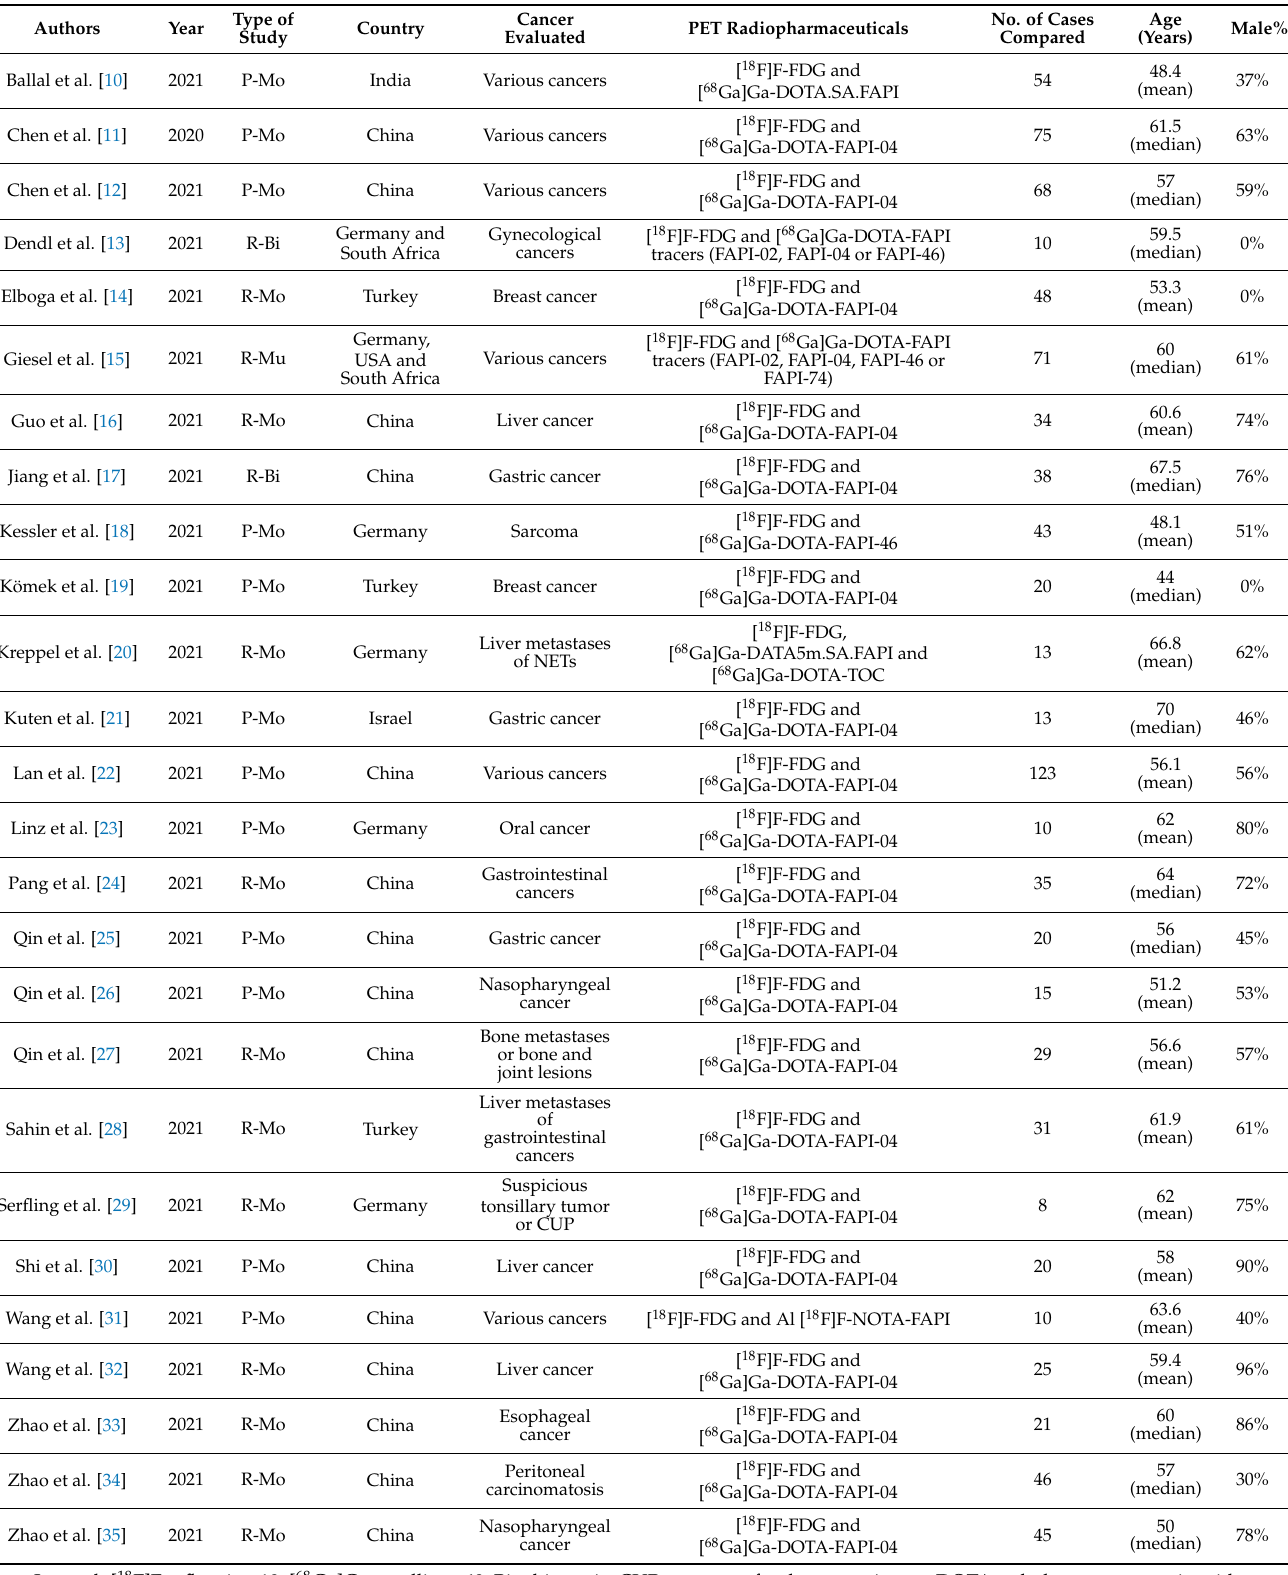
Table 1. Basic study and patient characteristics of the included